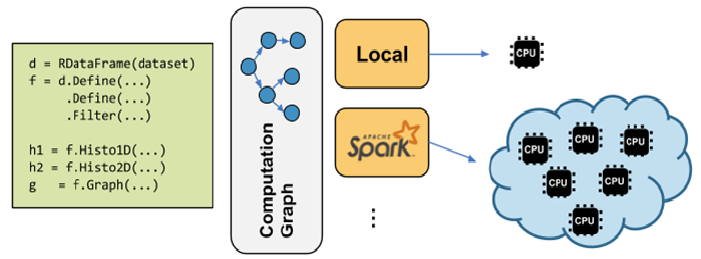
Figure 2. RDataFrame interface to computing resources. A pseudo-code snippet shows the high-level interface provided by RDataFrame, which internally determines how to distribute the computing tasks according to the available resources. Users can run their analysis on a small set of CPUs or at scale leveraging the Spark resources and task distribution layer without further modifications to the code.